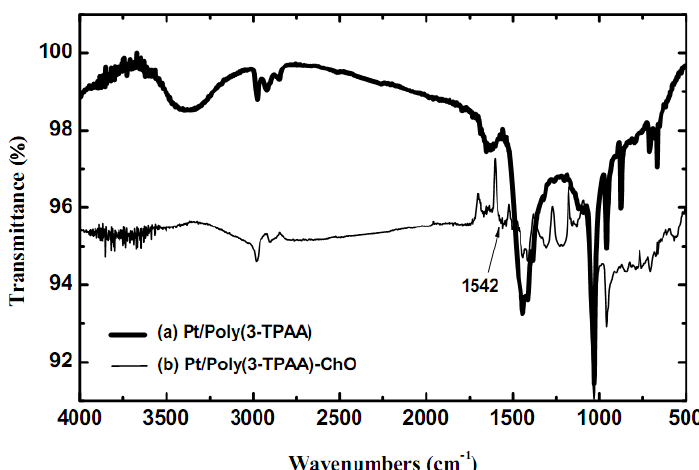
Figure 3. The FTIR spectra of Pt/poly(3-TPAA) film (bold line) and Pt/poly(3-TPAA)-ChO film (thin line) at room